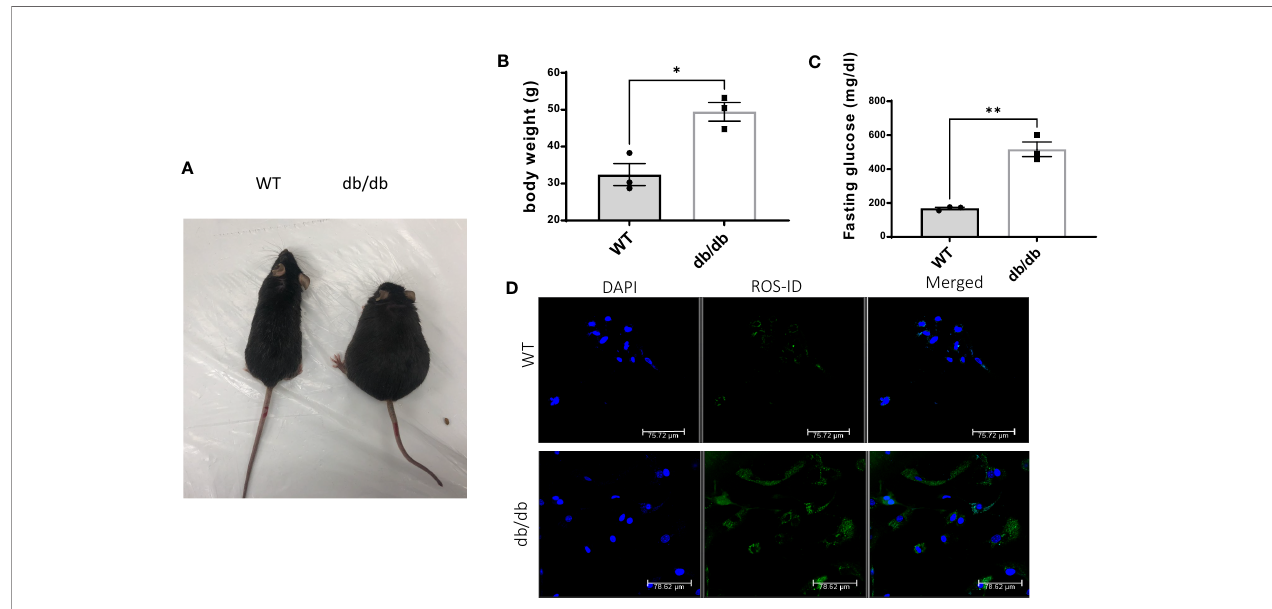
FIGURE 1 | Comparison of WT and db/db mice. (A) A db/db mouse in comparison to an age-matched C57BL/6 WT mouse; (B) Body weight (g) in 6-month-old WT mice and db/db mice; results are shown as mean ± SEM (n = 3, * p < 0.05); (C) Blood glucose levels (mg/dl) in 6-month-old WT mice and db/db mice fed with standard chow, (n = 3, **p < 0.01); (D) Green fl uorescence intensity was used as a measure of relative intracellular ROS in WT CMECs and diabetic